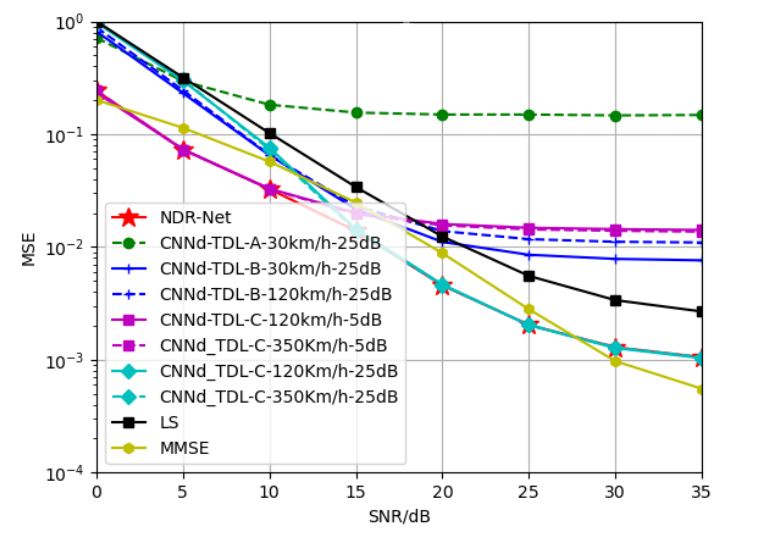
Figure 14. Generalization performance of different channel estimators when the test channel is TDL-C, SNR = 15 dB, Velocity = 350